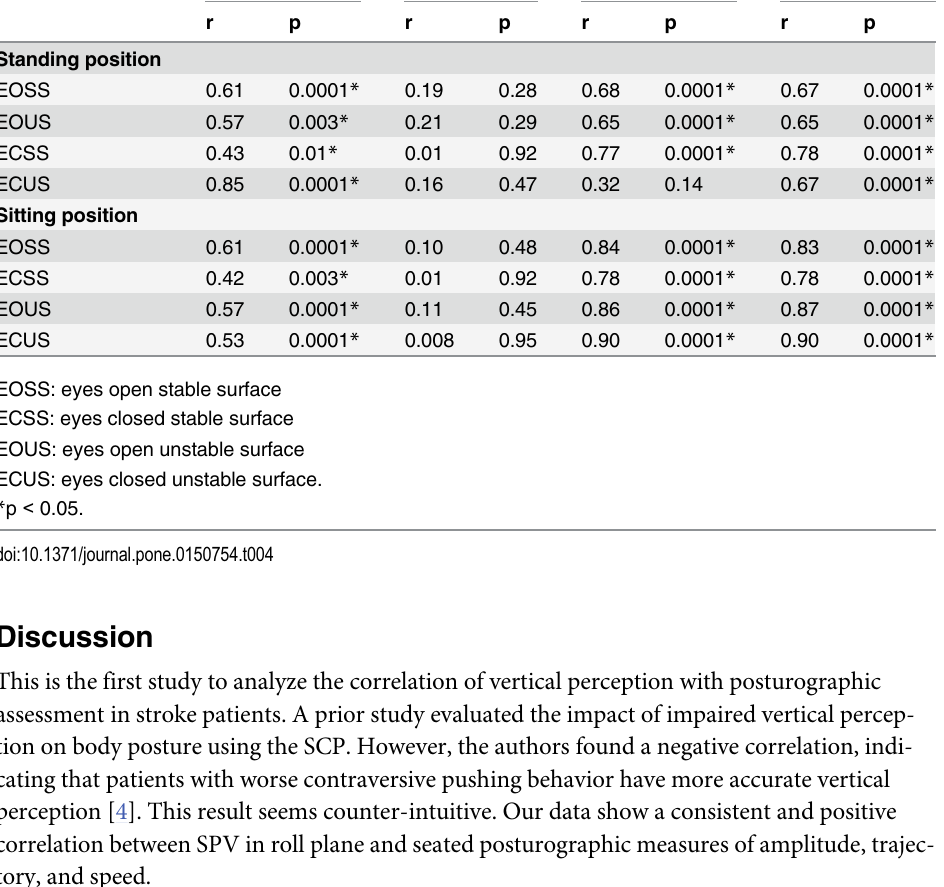
Table 4. Correlation between posturographic parameters in roll and pitch planes for each condition in standing and sitting position.